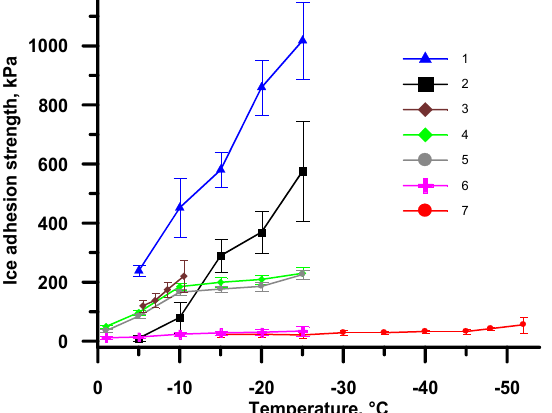
Figure 9. Temperature dependences of ice shear adhesion stress for di ff erent substrates: 1—ultra-smooth hydrophilic silica substrates (R a < 0.4 nm) [60]; 2—silica plates coated with an adsorbed diblock copolymer layer [78]; 3—superhydrophobic aluminum rod [103]; 4, 5, 6—micro-nano structured aluminum surface modified by perfluorooctyltrichlorosilane, polydimethylsiloxane (PDMS), and silicon-oil-infused PDMS-modified surface, respectively [12]; 7—dimethylolpropionic acid—polyurethane composite coating with an aqueous lubricating layer [109].